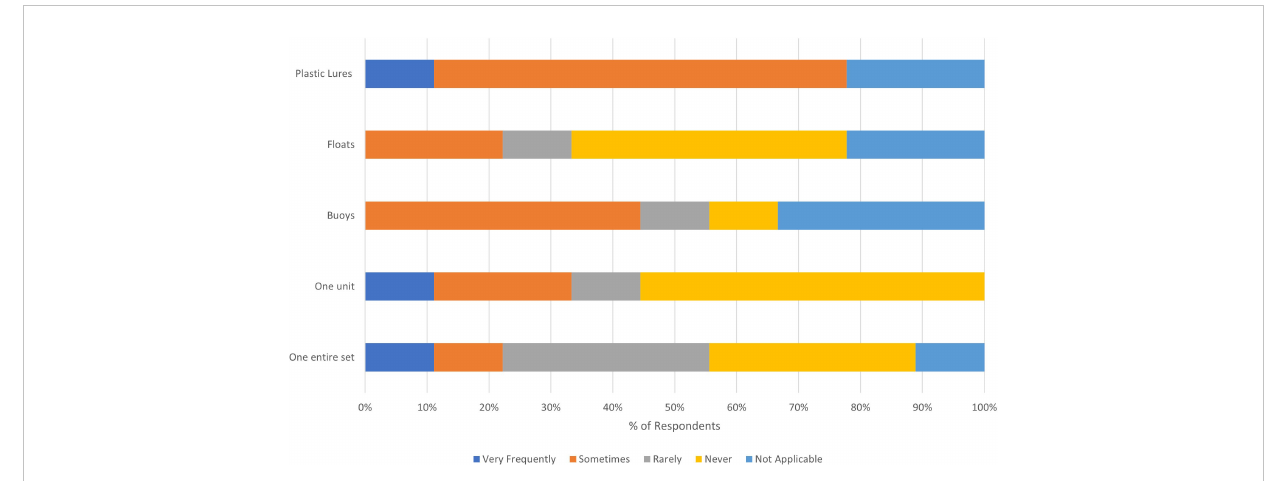
FIGURE 6 Summary of interview results from Antigua and Barbuda to the question: “ When or if fi shing gear with hooks and lines or parts thereof are lost which of the following elements are lost and at what frequency? ” (n =